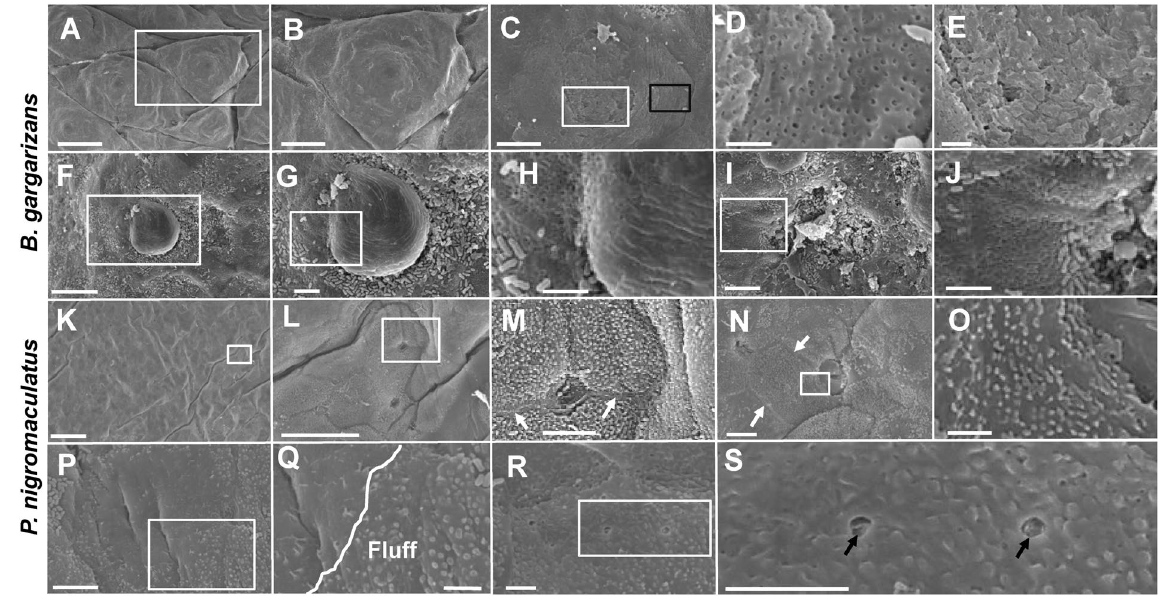
Figure 8. The surfaces of the ventral skin in B. gargarizans and P. nigromaculatus by SEM. SEM observations of the ventral skin in B. gargarizans and P. nigromaculatus . Surfaces of the ventral skin in B. gargarizans ( A–J ) and P. nigromaculatus ( K–S ). Plate in the ventral skins and granular gland ( A,B ). Ventral skin with superfine holes ( C,D ) and a scaly cuticle ( E ). Scale debris on skin with superfine holes ( F,H ). Superfine holes on the skin ( I,J ). Boundary among stratum corneum cells ( K–N ) with superfine fluff ( M–O ). Some fluff falls off and leaves a smooth surface ( P,Q ). The horny surface smashes, detaches and forms ultrafine pores ( R,S ). The white arrow shows the boundary among stratum corneum cells, and the black arrow shows the horny ultrafine pore. B, D, G, H, J, L, M, O, Q and S show enlarged images of the boxes in A, C, F, G, I, K, L, N, P and R, respectively. Scale bar, A: 500 μ m; B: 250 μ m; C, G, I, M, N, P, R: 5 μ m; D-E, H, J, O, Q, S: 2 μ m; F: 20 μ m; K: 100 μ m; L: 30 μ